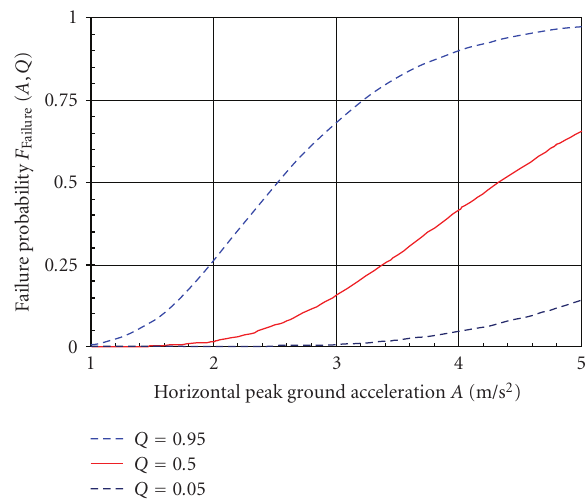
Figure 3: Example of a fragility curve for a building.